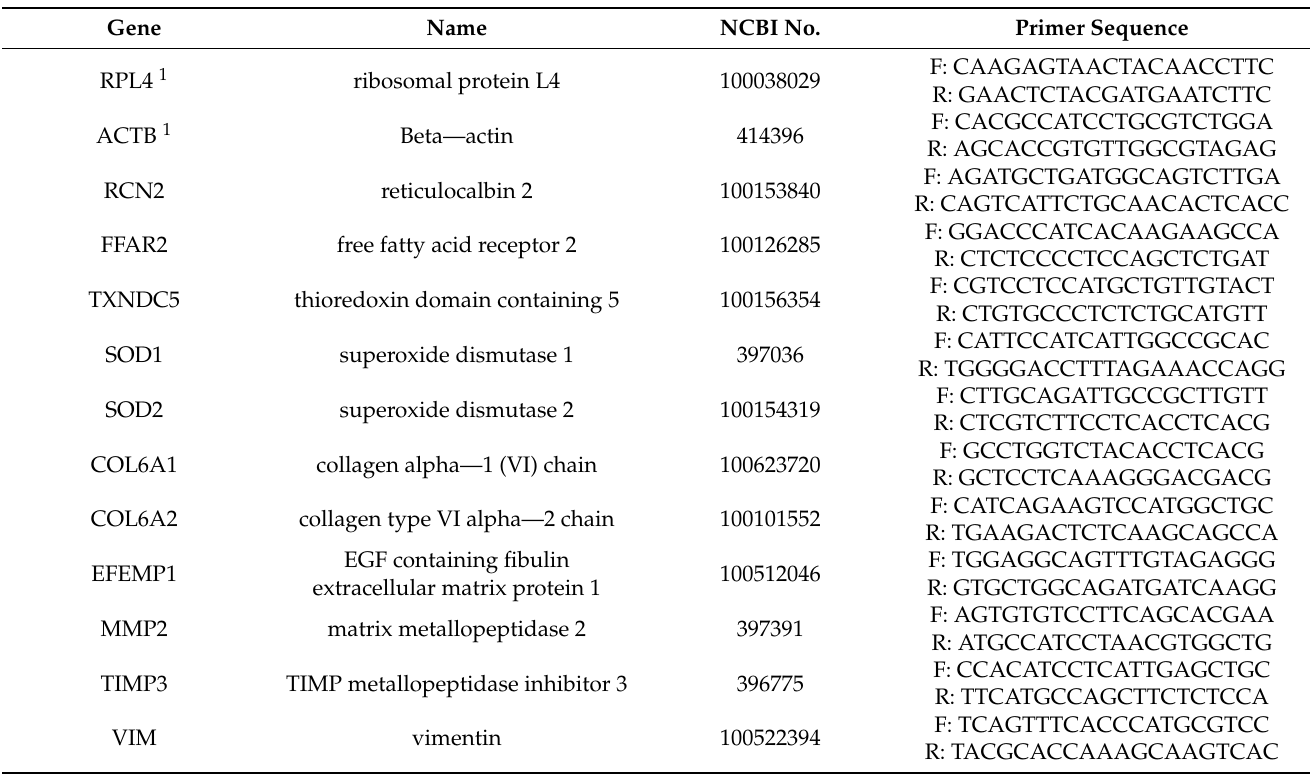
Table 2. Primer sequences used in RT-qPCR reaction (F—Forward primer; R—Reverse